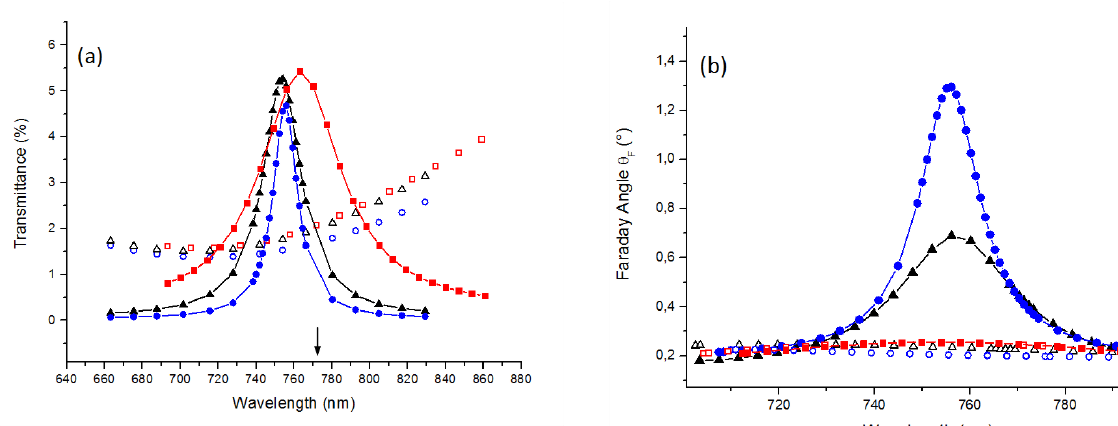
Figure 2. Transmittance spectra ( a ) and Faraday rotation spectra ( b ) for the nanocavity samples-1, 2 and 3 with Au layer on top (filled rectangles, triangles and circles, respectively) and for the “not covered” samples: Sample- 1nc, 2nc and 3nc (open rectangles, triangles, and circles, respectively). Arrow below indicates λ from (1) for the